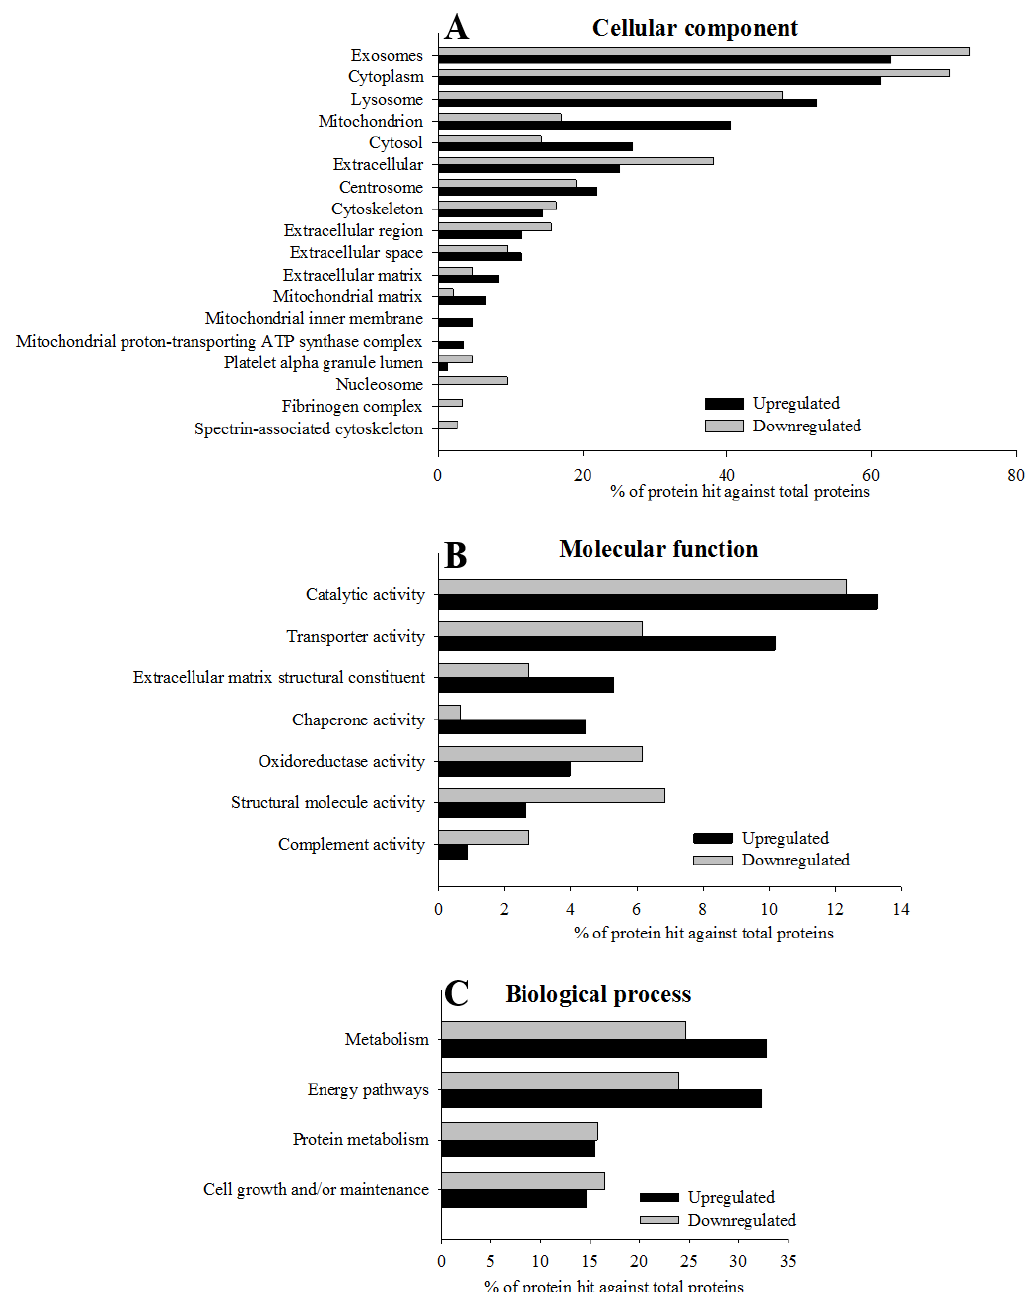
Figure 3. Gene ontology (GO) enrichment of 364 significantly regulated proteins according to the FunRich functional annotation. The histograms show for each GO term, cellular component ( A ; p < 10 − 5 ), biological process ( B ; p < 0.05) and molecular function ( C; p < 0.05), the most significantly enriched categories of up-regulated and down-regulated proteins quantified using the SWATH-MS approach. Extended data of GO enrichment analysis is provided in Table S3.